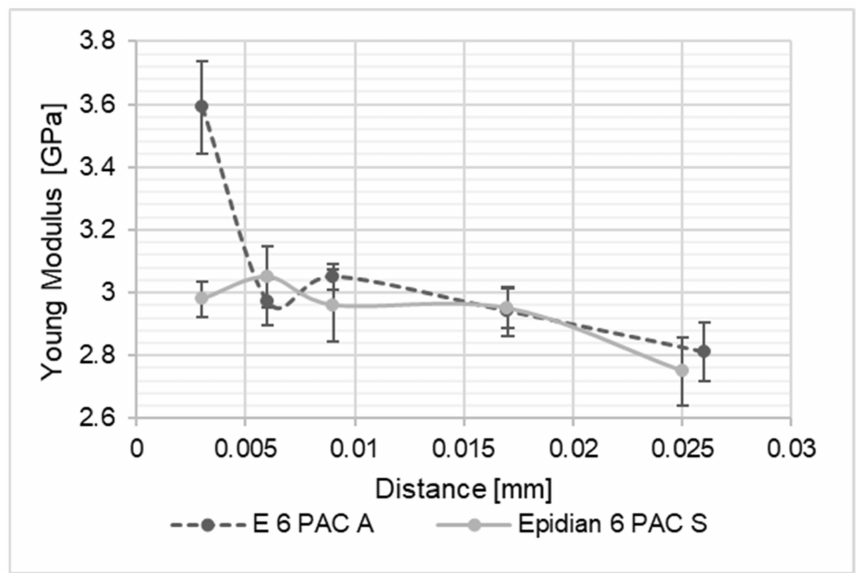
Figure 8. Comparison of Young’s modulus values for the Epidian 6/PAC joint bonding: A— aluminium alloy sheets; S—stainless steel sheets, as above.